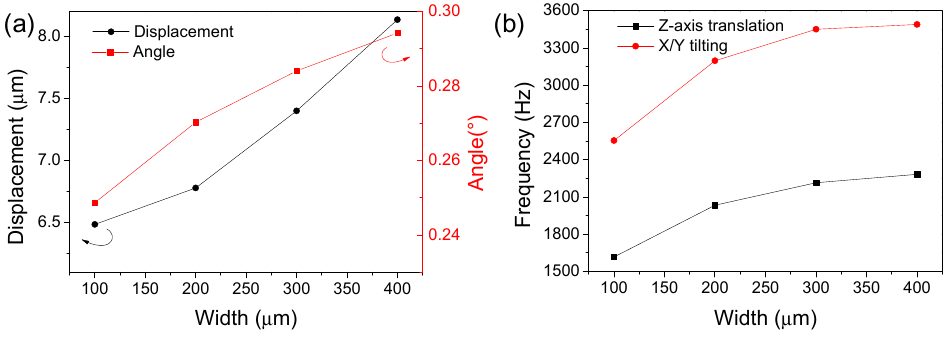
Figure 3. The effect of the width of beam on the ( a ) z-axis translation modal displacement, X/Y tilting inclination angle and ( b ) their corresponding resonant frequency.